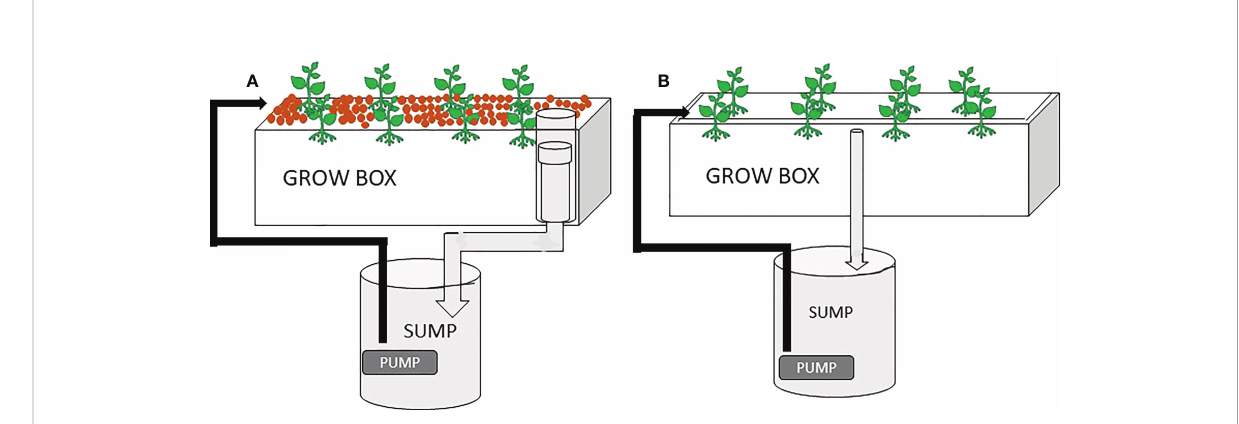
FIGURE 1 The schematic design showing the sample media bed system (A) , consisting of grow pebbles, bell siphon outlet, 0.2 m 2 grow box, 40 L sump bucket, water fl ow pipes, submersible pump and basil plants; and the raft system (B) , consisting of 0.2 m 2 grow box, polystyrene grow foam, 40 L sump bucket, submersible pump, water fl ow pipes, and basil